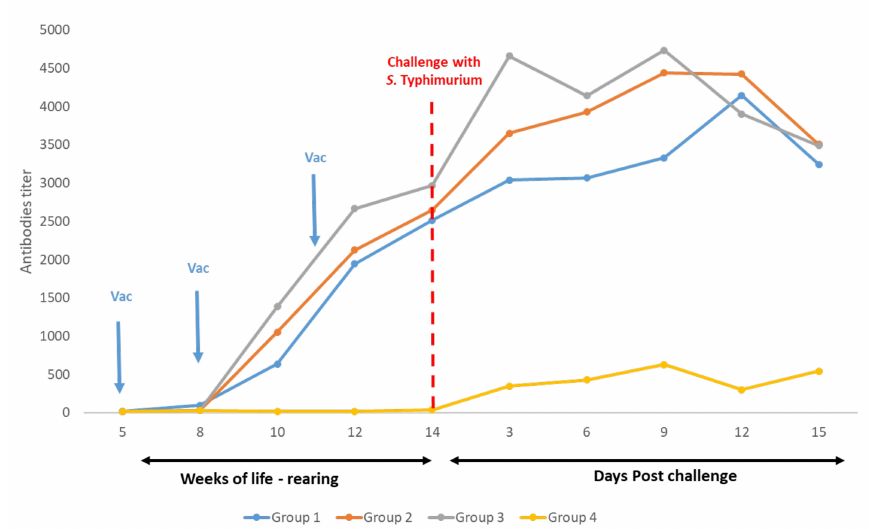
Figure 2. Trial 2—Antibodies titres. Measurements of antibody titres in vaccinated and non- vaccinated chickens. Challenge with S. Typhimurium (ST) was carried out in week 14 of life (red line). Blood samples were taken approximately every 10 days starting at week 5 of life, and after the challenge, samples were taken every three days until day 15 post-challenge, when all birds were euthanized. Sera were analysed by ELISA (Salm Gp B, Biochek).